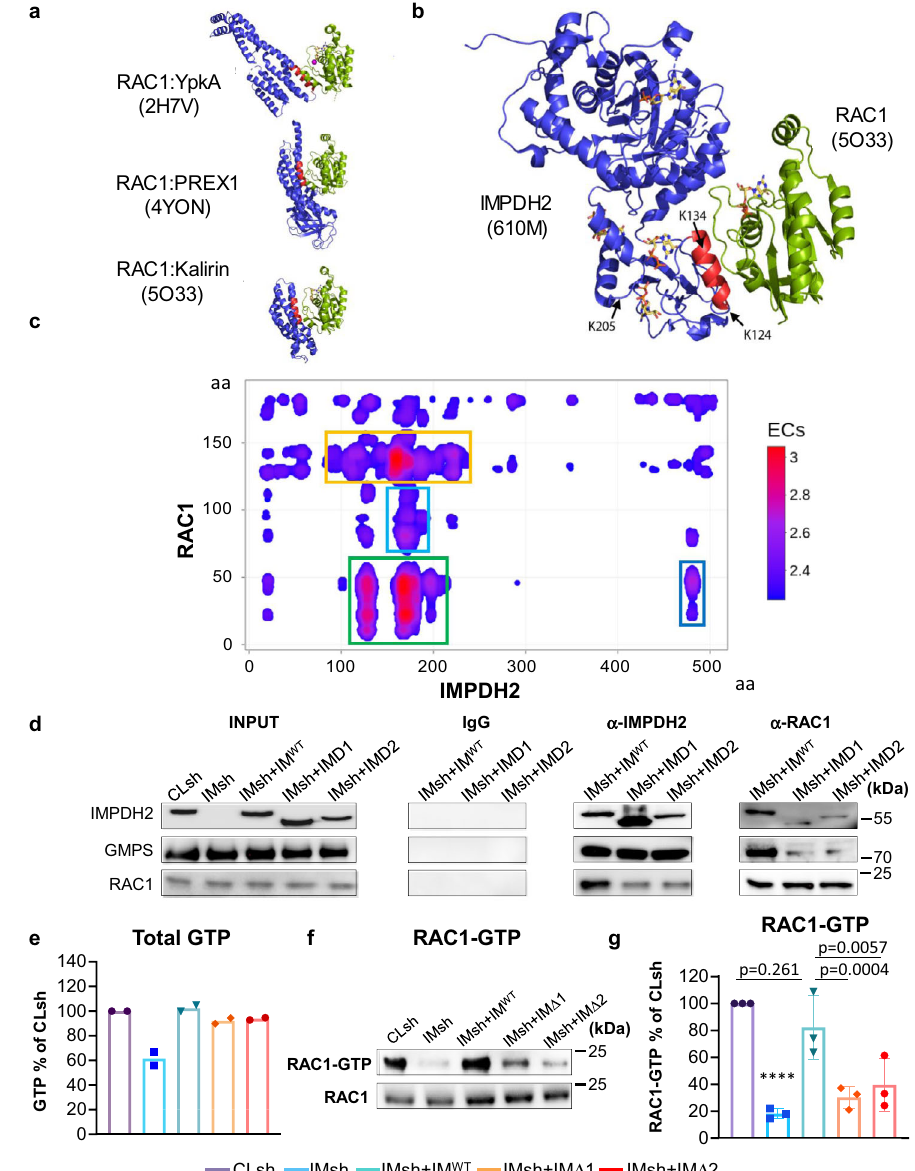
Fig. 5 Delineation of IMPDH2 – RAC1 interactions. a Structures of RAC1 (shown in green) in complex with other indicated proteins (shown in blue). The number in parenthesis indicates the corresponding entry in RCSB (Research Collaboratory for Structural Bioinformatics) Protein Data Bank. Note that RAC1 binds to α -helices (shown in red) in the target proteins. b A model of the IMPDH2 – RAC1 interaction was created by superimposing the α -helix of IMPDH2 containing K134 (shown in red) onto the analogous helix in the RAC1-Kalirin complex. c Convolved evolutionary coupling of IMPDH2 and RAC1. Strength of the couplings between residues of the two proteins are color-coded with red color denoting the highest probability. Shown in colored frames are regions with a high (green), intermediate (yellow), and low (blue) probability of interactions. d Cells were transduced with control shRNA (Cl sh), IMPDH2 shRNA (IMsh), or IMPDH2 shRNA in combination with wild-type IMPDH2 (IM WT ), IMPDH2 lacking 153-225 aa (IM Δ 1), or IMPDH2 lacking 101-134 aa (IM Δ 2). Cells were subjected to immunoprecipitation with the antibodies indicated on the top. The immunoprecipitated materials were probed in immunoblotting with the antibodies indicated on the left. Shown are representative images of at least two independent experiments. e GTP levels were determined via mass spectroscopy as described in Methods. The data represents the average ± SEM of two independent experiments performed in duplicates. Statistics performed by two-tailed unpaired Student ’ s t -test (**** p < 0.0001), exact p value < 0.00001. The data represents the average ± SEM of two independent experiments performed in duplicates. f Cells transduced with the indicated constructs were probed in RAC1 activity assay as described in Methods. Shown are representative images of at three independent experiments. g Quanti fi cation of ( f ). The data represents the average ± SEM of three independent experiments. Statistics were performed by a two-tailed unpaired Student ’ s t